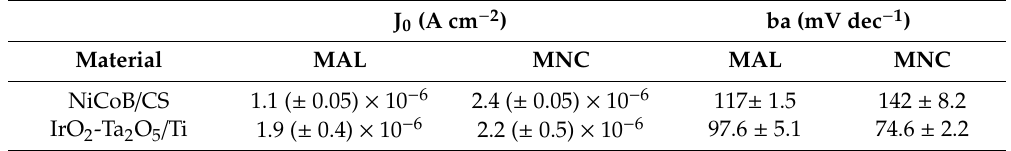
Table 4. Exchange current density (J 0 ) and Tafel’s slope of NiCoB / CS and IrO 2 -Ta 2 O 5 / Ti